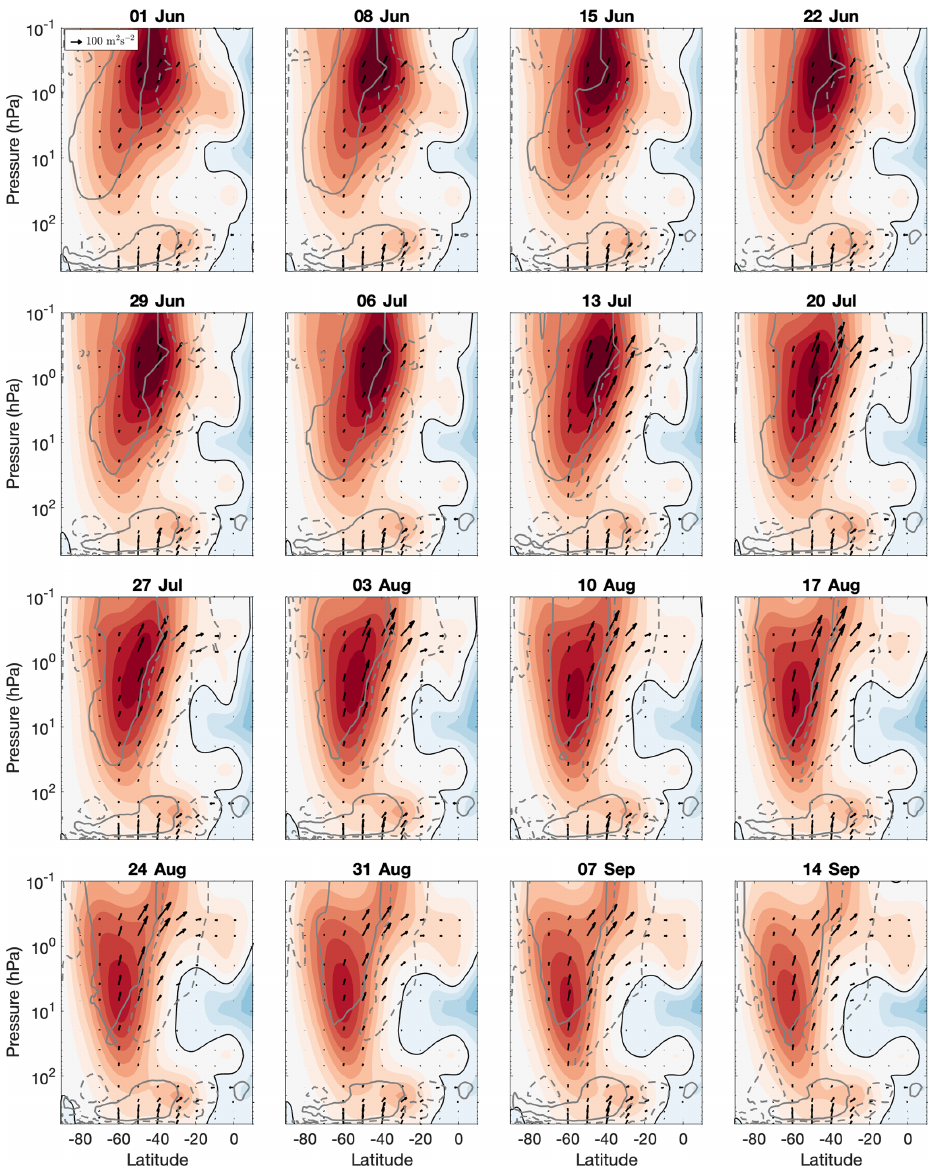
Figure 1. The 7d average zonal-mean zonal wind (contours, interval 10ms − 1 ), Eliassen–Palm (EP) flux (arrows, m 2 s − 2 , reference arrow shown in first panel) and EP flux divergence ( ± 2ms − 1 d − 1 , convergence is indicated by dashed grey lines, and divergence is indicated by solid grey lines) for the reference eQBO years (excluding 1988, 2002, 2017, and 2019). Each panel covers the latitudinal range of 90 ◦ S to 10 ◦ N and the vertical range of 550 to 0.1hPa. The solid black line shows the location of the zero-wind line. The first day of averaging in each figure is given in the